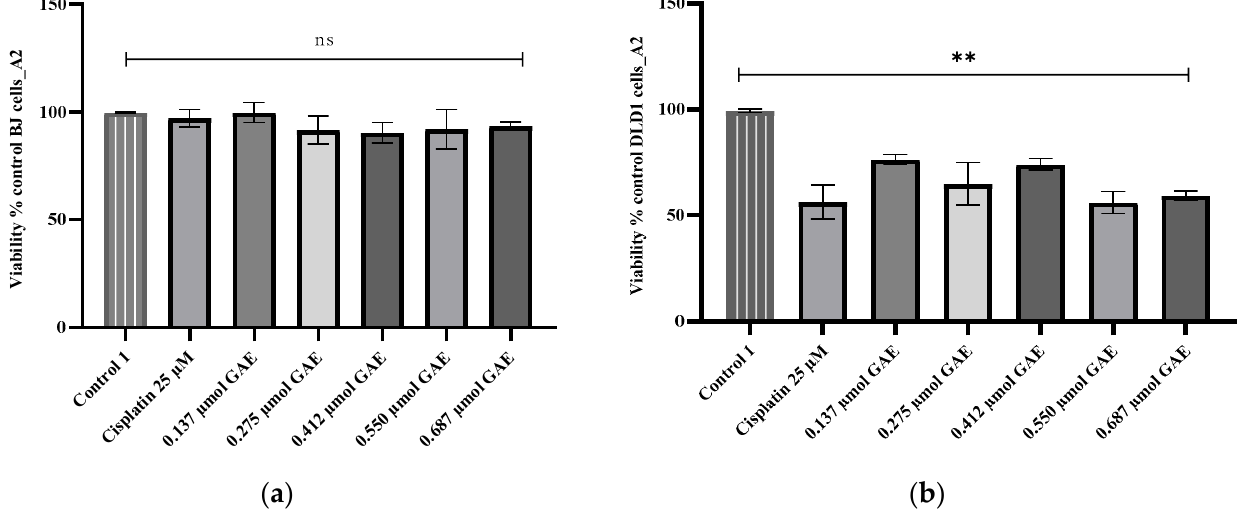
Figure 1. Viability percentages obtained for ( a ) BJ and ( b ) DLD-1 cells after 24 h incubation with A1 extract. The A1 concentrations were calculated according to the TPC µmol GAE (0.142–0.714 µmol GAE). Control 1 (negative control)—untreated cells; control 2—cells treated with cisplatin (25 µM). Data represent the mean ± SD of three independent experiments; ns—no significant differences; **— p < 0.05.